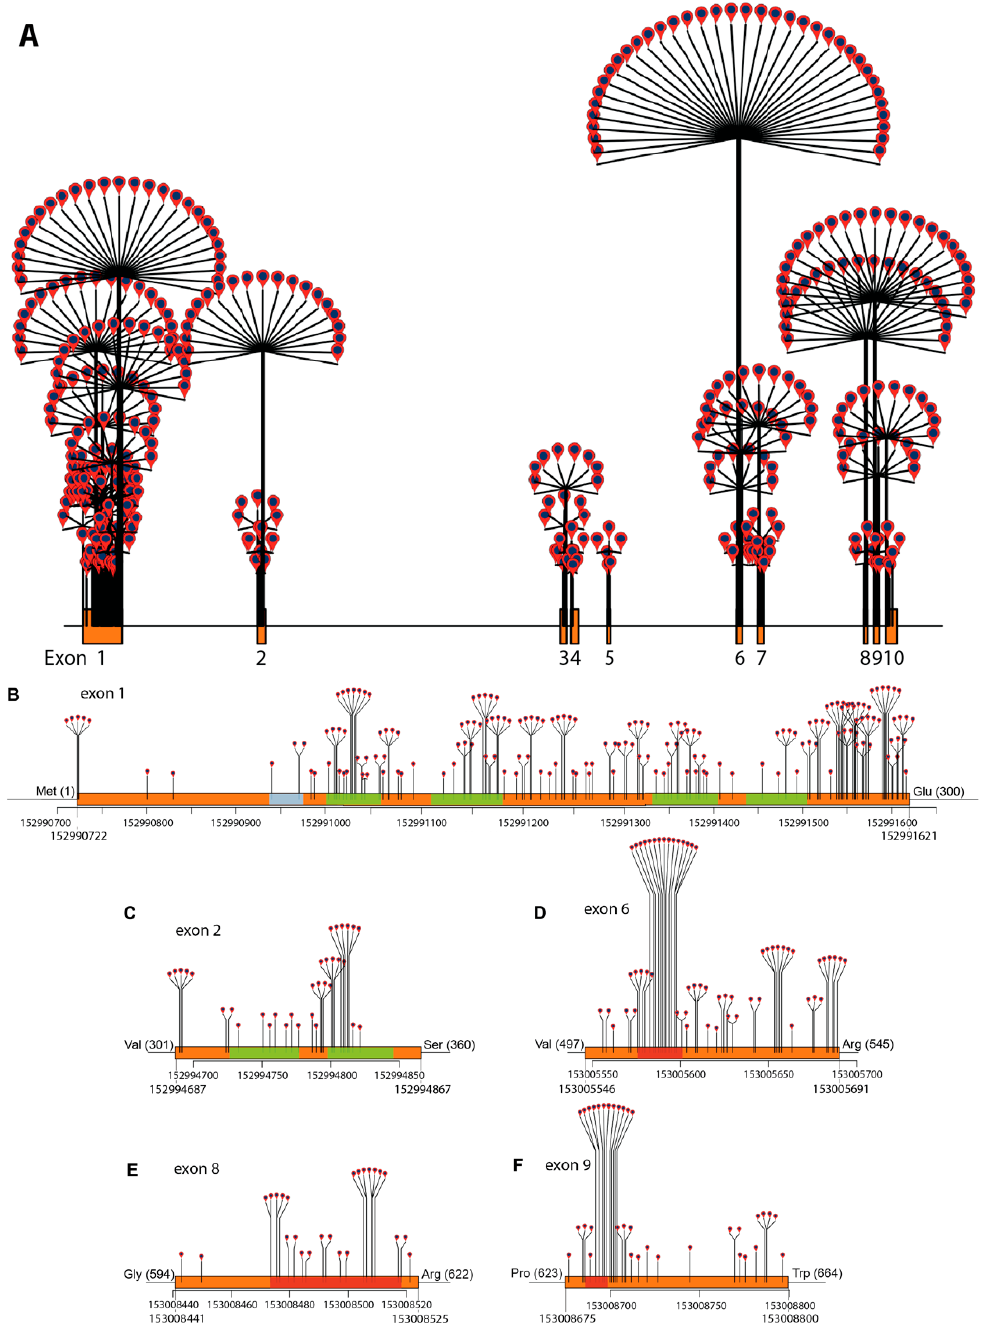
Figure 2. Missense variant density by chromosome position: ( A ) across the ABCD1 gene, ( B ) exon 1, ( C ) exon 2, ( D ) exon 6, ( E ) exon 8, and ( F ) exon 9. Exons are indicated in orange, the PEX19-binding site is indicated in blue, the transmembrane segments are indicated in green and Walker A and B and the ABC signature are indicated in red.